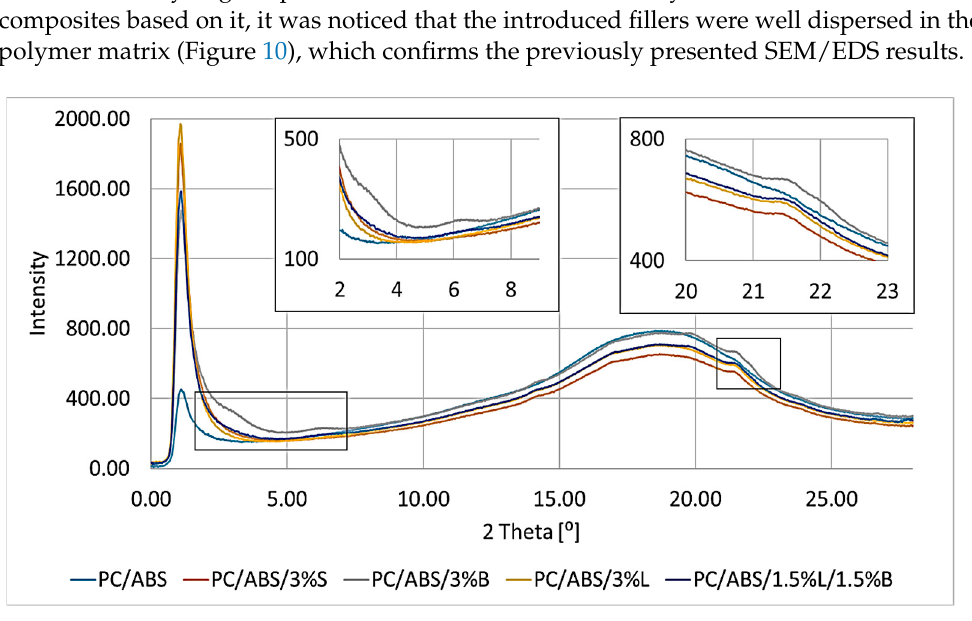
Figure 10. Results of the WAXS study of the composites.